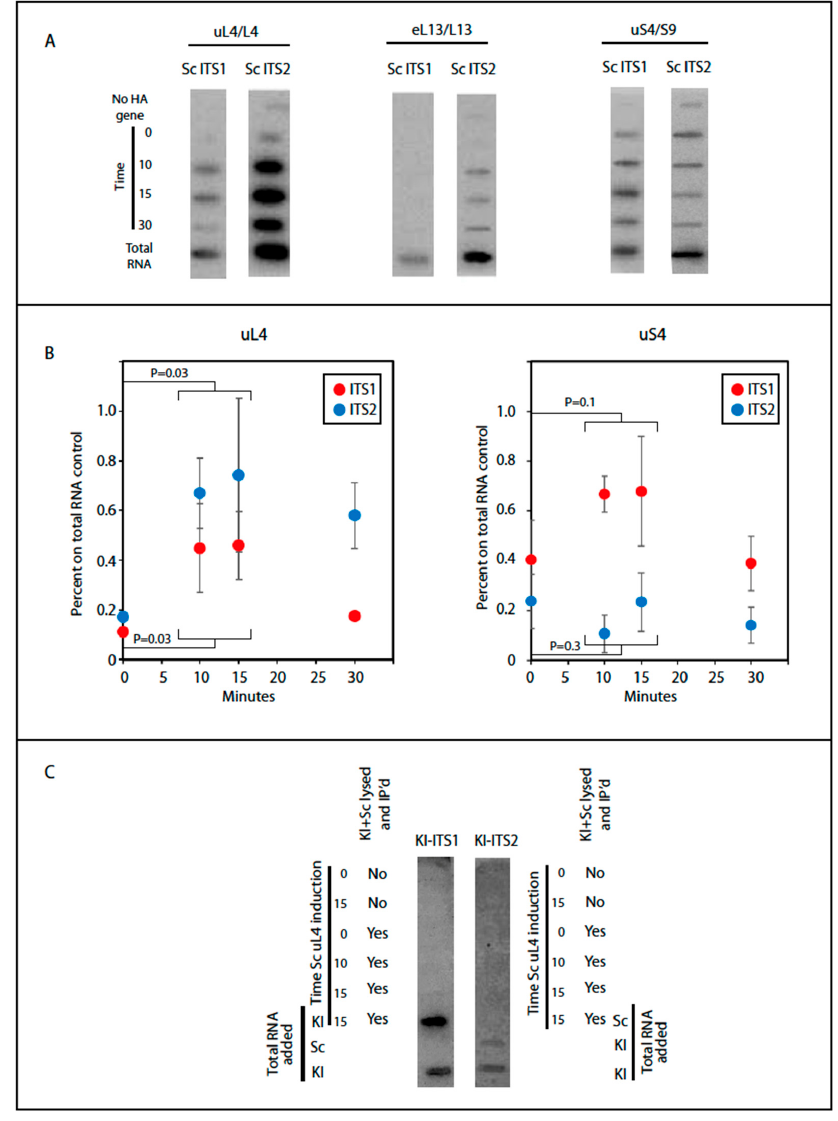
Figure 5. Co-purification of transcribed spacer sequences with HA-tagged ribosomal proteins. Cells were induced for the indicated HA-tagged r-protein for 0, 10, 15, and 30 min. Ribosomal particles were then purified from whole cell lysates using beads coated with anti-HA. ( A ) RNA was extracted from the purified particles and loaded onto a membrane in a slot pattern and probed with 32 P end-labeled oligonucleotides complementary to segments of ITS1 or ITS2 in S. cerevisiae (Sc); see Figure 1A. Slots loaded with total RNA purified from Sc whole cell extracts were used as controls. ( B ) The bands from the uL4 and uS4 immuno-purification in panels A were quantified, normalized to the values for total RNA, and corrected for background from the cells without the plasmid-borne inducible r-protein genes. The results were plotted against time of induction. The combined values for t = 10 and 15 were compared statistically to values at t = 0 by t -test and the P values are indicated. ( C ) Control for unspecific binding of ITS RNA to HA-uL4 containing ribosomal particles after lysis. Sc cells induced for HA-uL4 synthesis for 0, 10, or 15 min were mixed with an equal number of OD 600 units of K. lactis (Kl) and the mix of Sc and Kl cells were lysed together. Lysates were also prepared from Sc cells induced for 0 and 15 min without mixing with Kl cells. HA-containing particles were purified on beads and RNA extracted from the purified particles was used for making a slot blot. Where indicated, the lysate was mixed with total RNA from Kl or Sc. Finally, the slot blot was probed with 32 P end-labeled oligonucleotides specific for Kl ITS1 or ITS2, see Figure